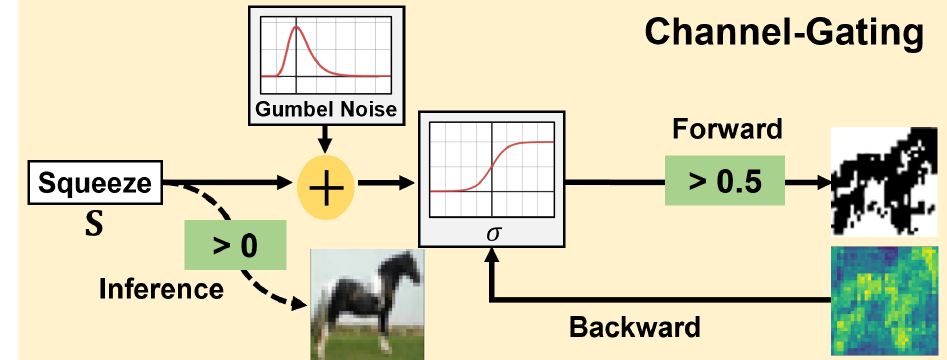
Figure 2. Forward and backward propagation in CG: forward and backward paths exploit hard and soft values for the gradient, respectively. In the inference process, the sparsity mask is generated without Gumbel